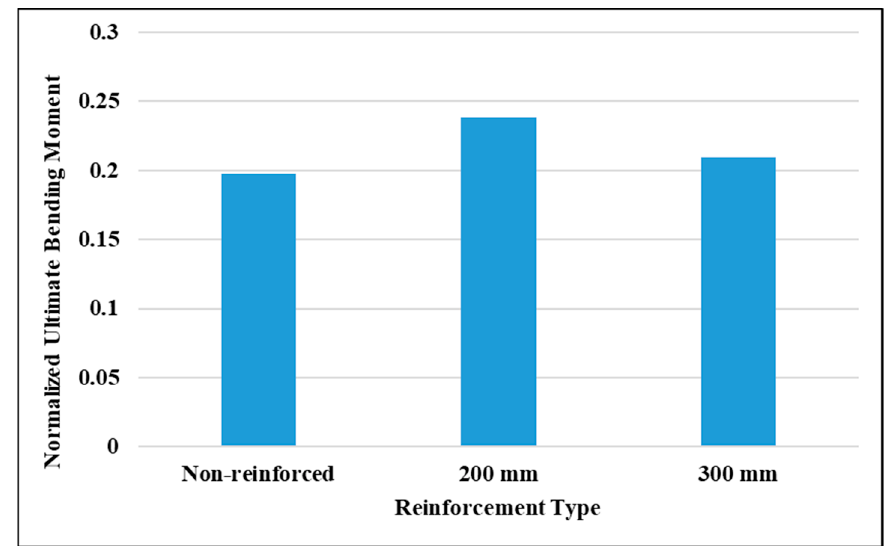
Figure 21. The ultimate normalized moment for the minor axis test by reinforcement type.